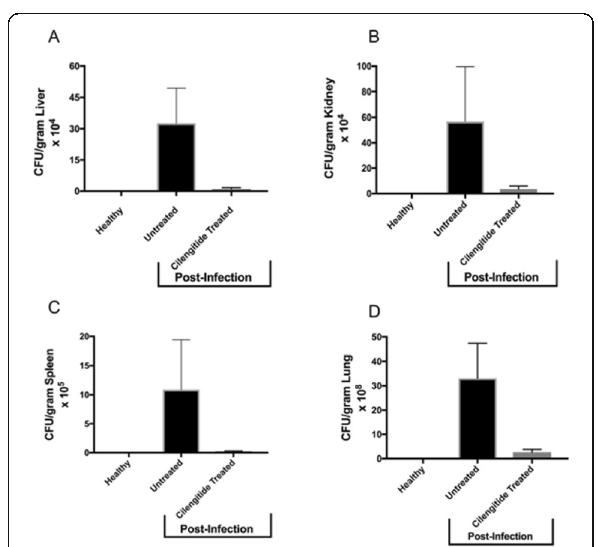
Fig. 4 (abstract P40). See text for